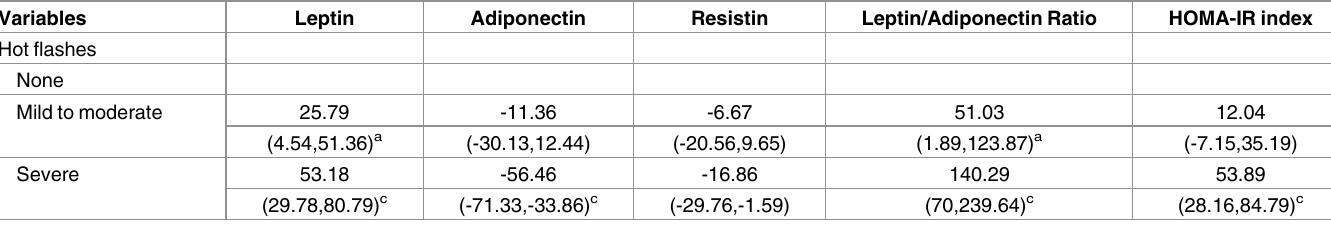
Table 2. Association of hot flash status with adipocyte-derived hormones and HOMA-IR.